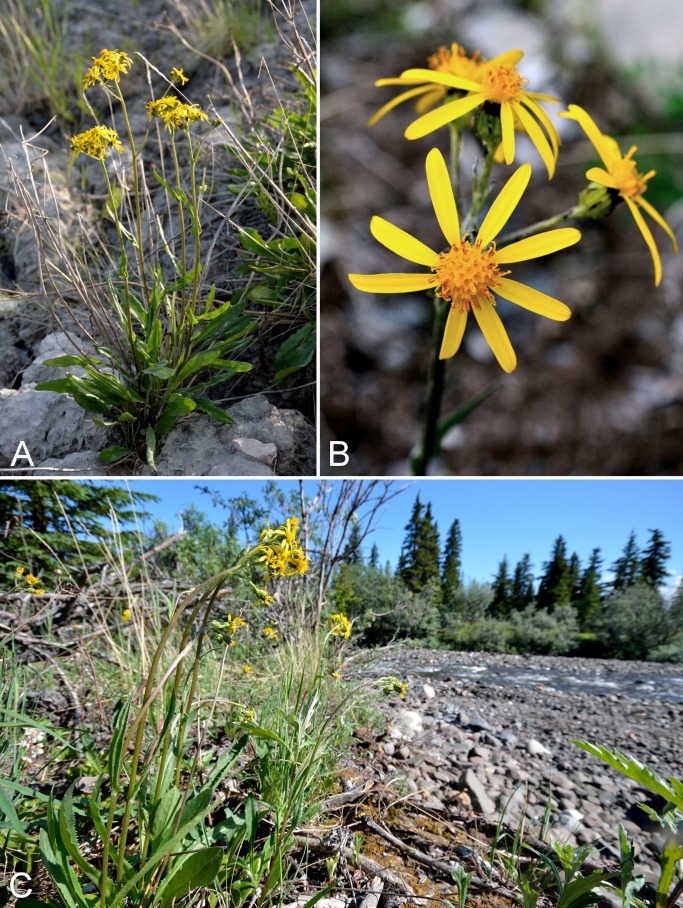
Senecio lugens.(A) Habit, Saarela et al. 3960. (B) Capitula, Saarela et al. 3192. (C) Habitat, Saarela et al. 3960. Photographs by R. D. Bull (A, C) and P. C. Sokoloff (B).